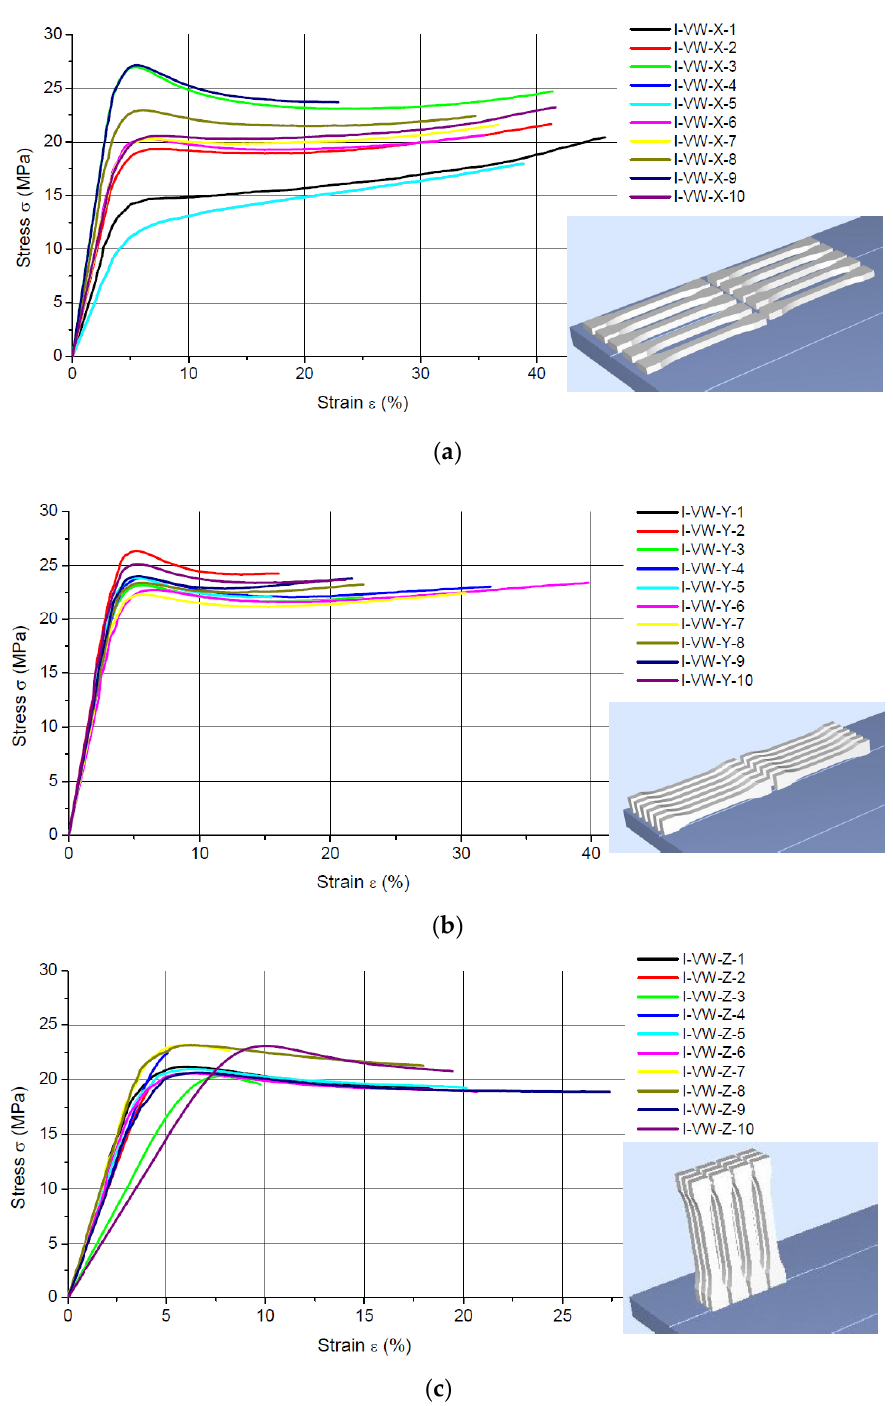
Figure 3. Tensile test data for naturally aged specimens 3D printed using VeroWhite photosensitive resin in: ( a ) the X direction; ( b ) the Y direction; ( c ) the Z direction. The ultimate tensile strength and the maximum strain of the specimens made of FullCure 720 and VeroWhite resins are provided in Tables 1 and 2, respectively. The last two rows show the mean values of the tensile strength R m and the maximum percentage strain ε m and the standard deviation for the particular measurement series. Table 1. Ultimate tensile strength and the maximum percentage strain for the FullCure 720 speci- mens.